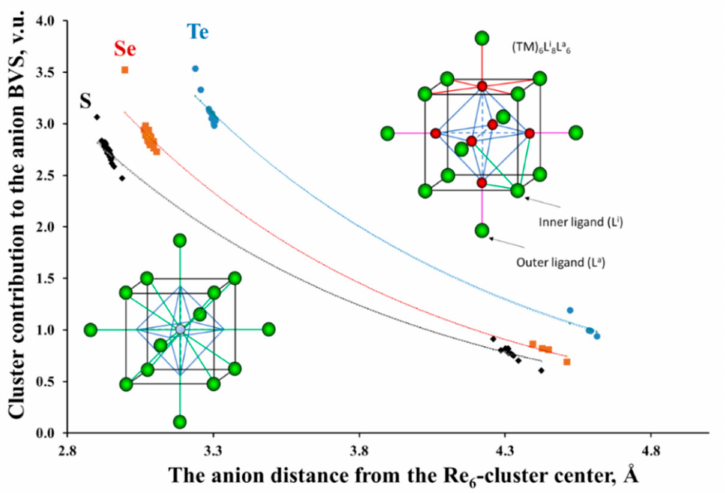
Figure 3. Re 6 cluster contribution to the ligand valence as a function of their distance from the cluster center in cluster compounds with Re 6 L 8 -core (L = S, Se, Te). The upper inset shows the cluster unit Re 6 L i 8 L a 6 . The rhenium and chalcogen atoms are in red and green, respectively. Re-Re bonds in octahedral clusters are marked in blue. The Re-L bonds around Re, inner and outer ligands are in red, green and pink, respectively. In the low inset, the cluster is replaced by a single